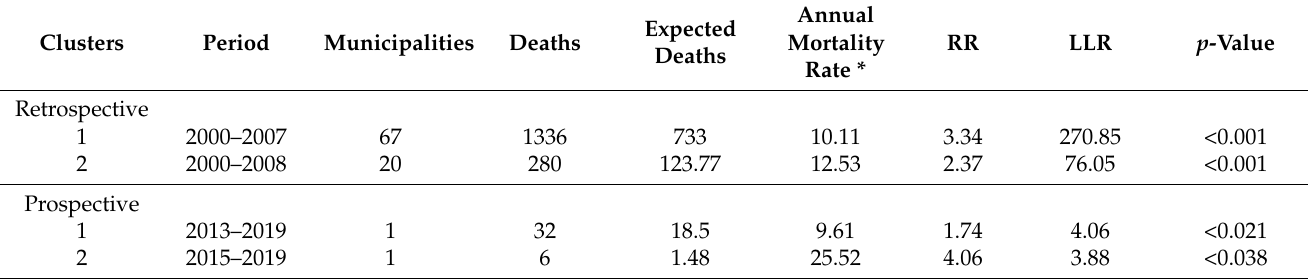
Figure 3. Spatiotemporal statistical analysis and clusters of deaths from diarrhea and infectious gastroenteritis in municipalities in the state of Alagoas, Northeastern Brazil, between 2000 and 2019. ( A ) Retrospective spatiotemporal scanning. ( B ) Prospective spatiotemporal scanning. Table 3. Retrospective and prospective spatiotemporal scanning and risk clusters of the mortality rate from diarrhea and infectious gastroenteritis, in the state of Alagoas, Northeast Brazil between 2000 to 2019.